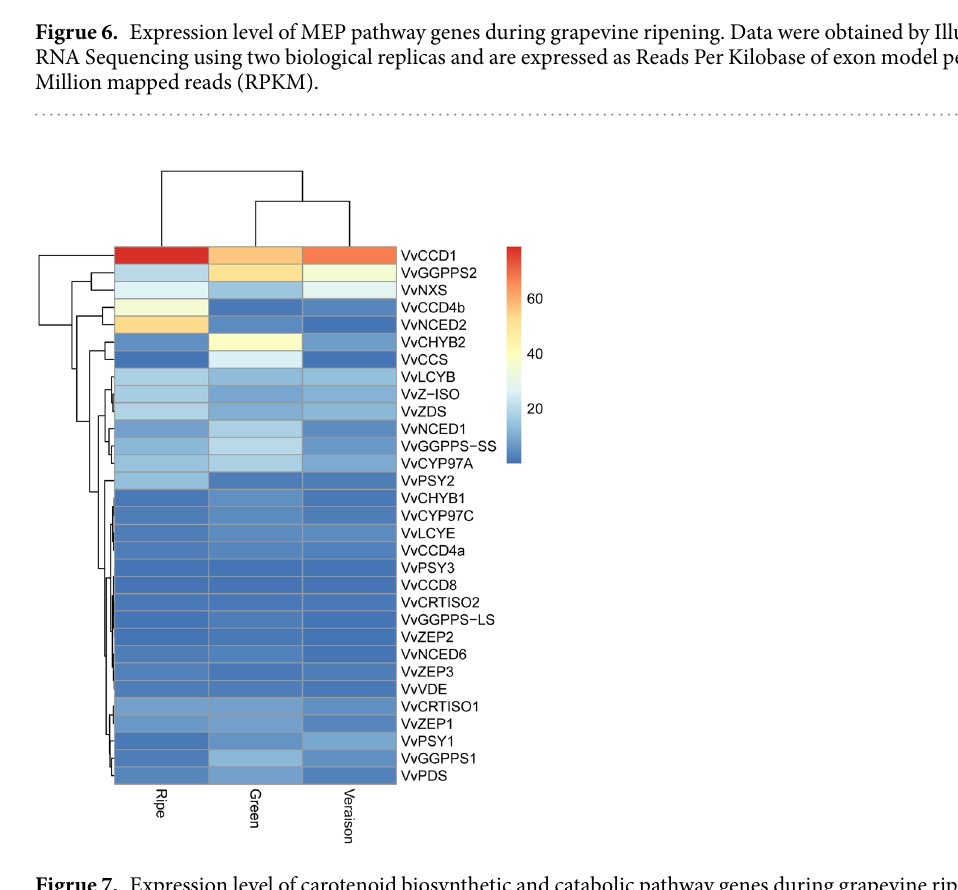
Figrue 7. Expression level of carotenoid biosynthetic and catabolic pathway genes during grapevine ripening. Data were obtained by Illumina RNA Sequencing using two biological replicas and are expressed as Reads Per Kilobase of exon model per Million mapped reads